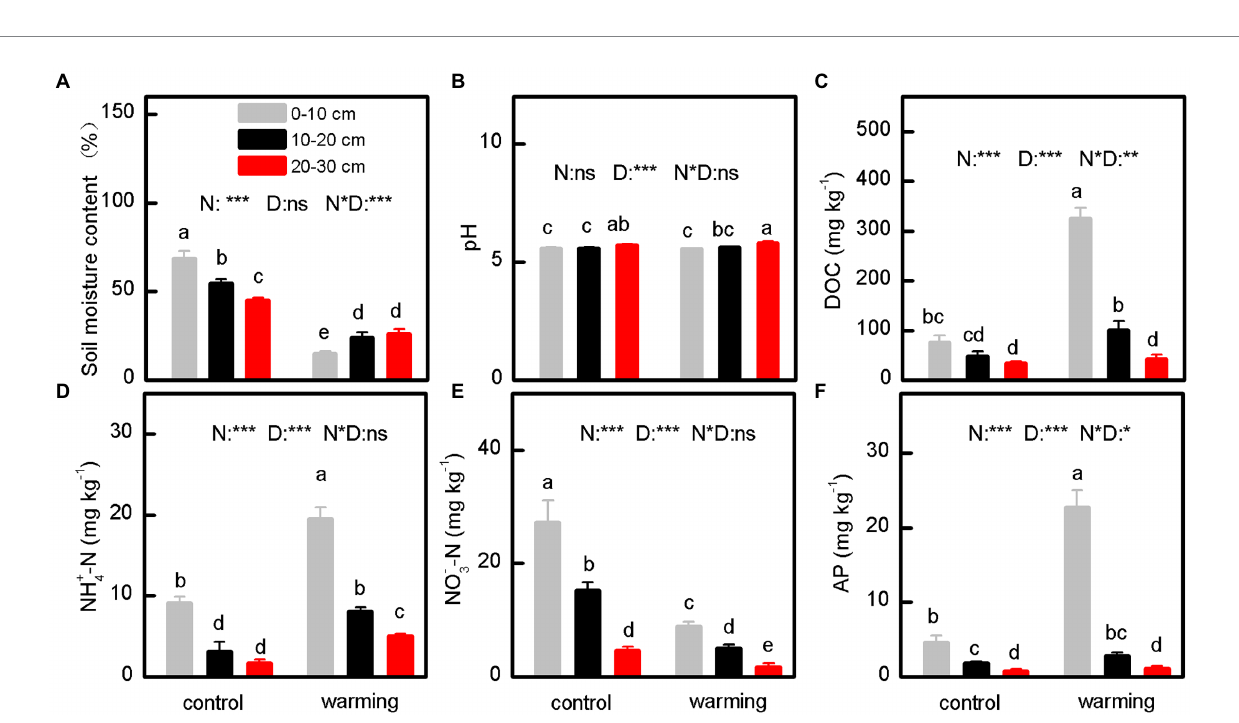
FIGURE 2 The SMC (soil moisture content) (A) , pH (B) , DOC (dissolved organic carbon) (C) , NH 4+ -N (ammonium nitrogen) (D) , NO 3 − -N (nitrate nitrogen) (E) and AP (available phosphorus) (F) of soil under control and warming. p -value of the ANOVA of treatments (control and warming, N), soil depths (0–10, 10–20 and 20–30 cm, D) and interactive of treatments and soil depths (N*D) is indicated: * p ≤ 0.05; ** p ≤ 0.01; *** p ≤ 0.001; ns, not